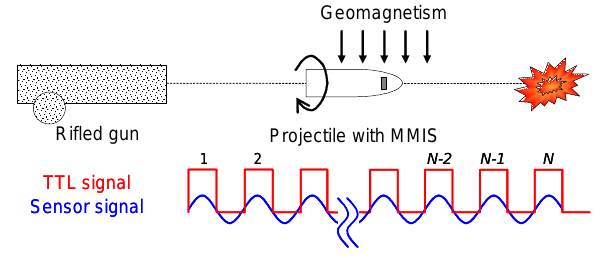
Figure 4. Working principle of turn-counting fuze with